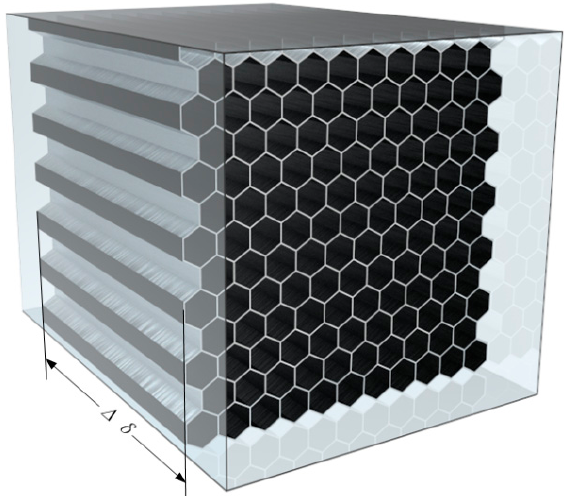
Figure 7. Finite element model of the honeycomb based on porous grid.